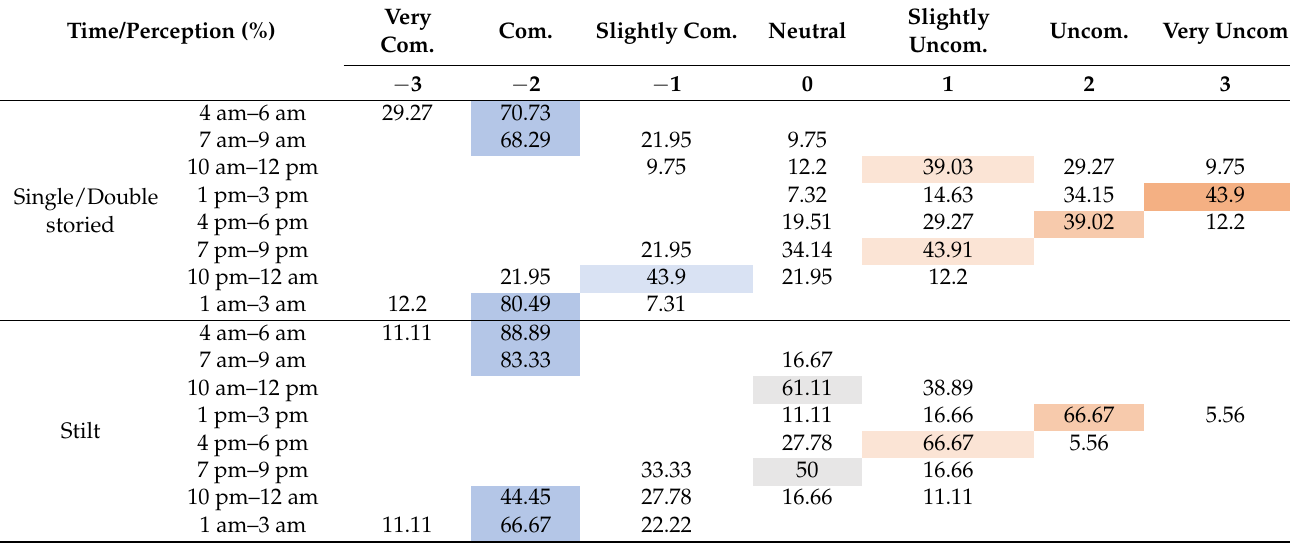
Table A3. Thermal perception of